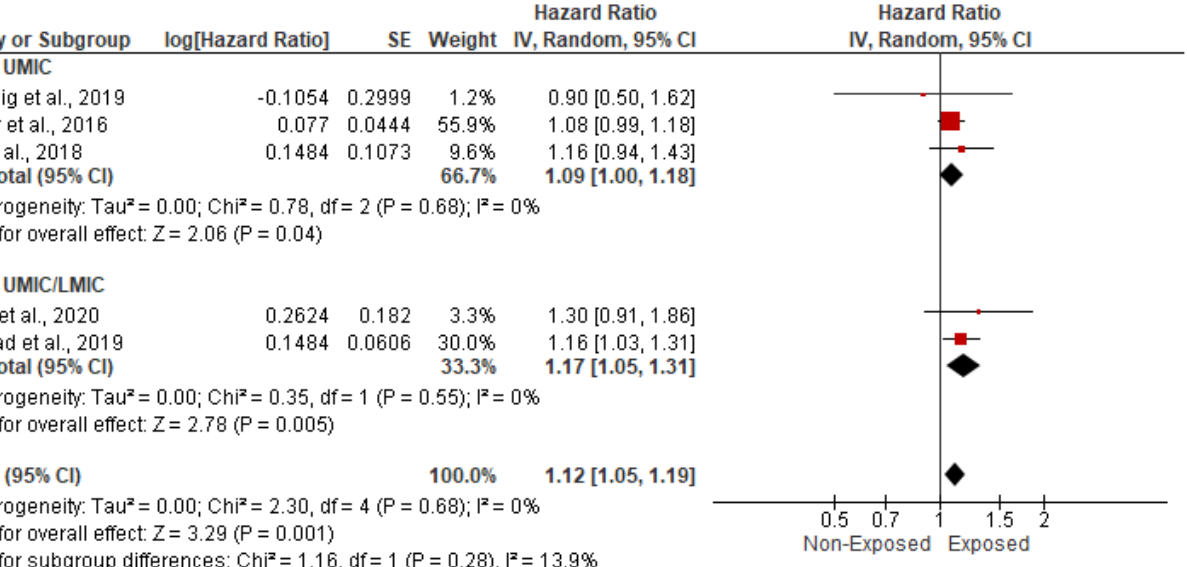
Figure 7. Funnel plot of the observed and plotted studies for assessing the association between HAP and cerebrovascular accidents after using the trim and fill method of Duvall and Tweedie. The white circles represent the observed studies, and the black circles represent the plotted studies.